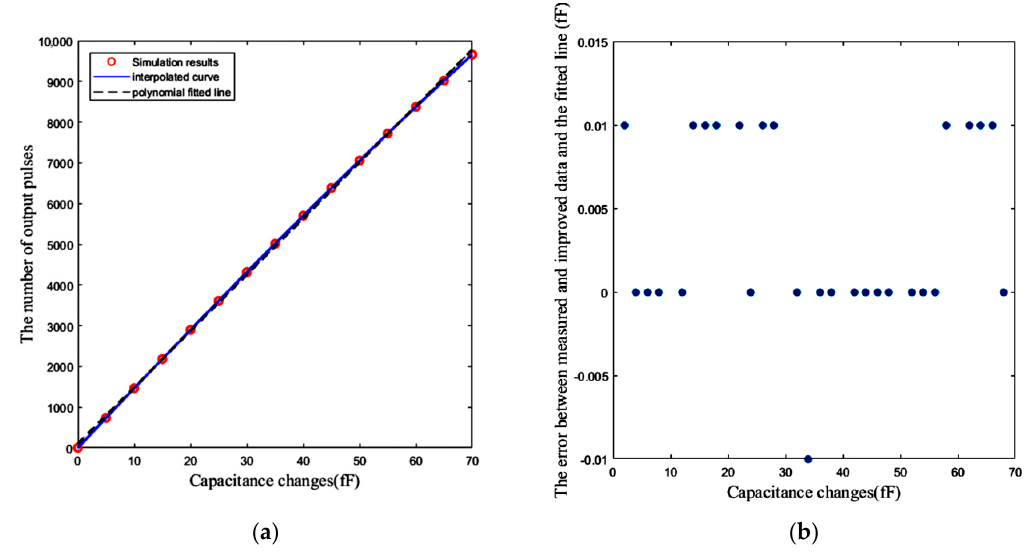
Figure 20. ( a ) Fifteen measured number of pulses versus capacitance changes Δ C (fF) at 27 °C, and the interpolated curve and the polynomial fitted line to these 15 points. ( b ) The error between the measured numbers of pulses related to the other values of Δ C after pre-distortion, and the polynomial fitted line.